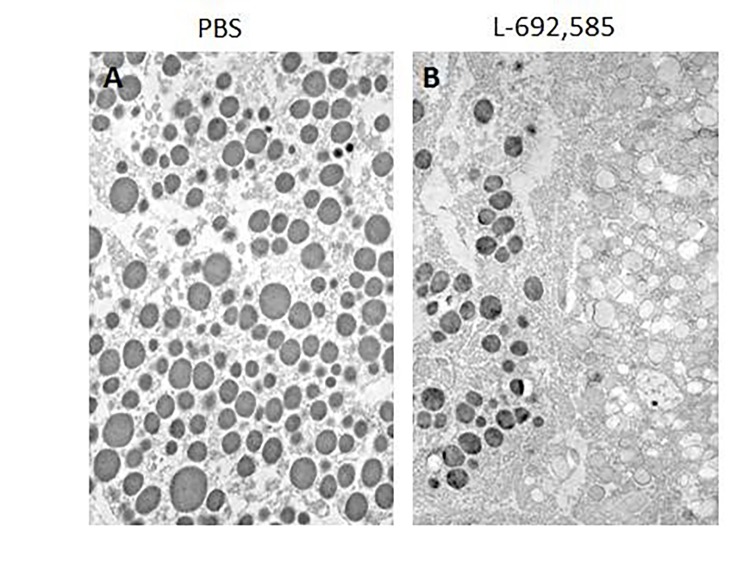
TEM images of immunogold labeled secretory vesicles in GH cellsNote localization of GH is only in electron dense vesicles in both control (resting) (A) and stimulated (B) cells. After stimulation of GH secretion with the secretagogue, L-692,585, for 90 s, there was complete absence of immunogold labeled GH-antibody in empty vesicles (B), Magnification, × 28,000.